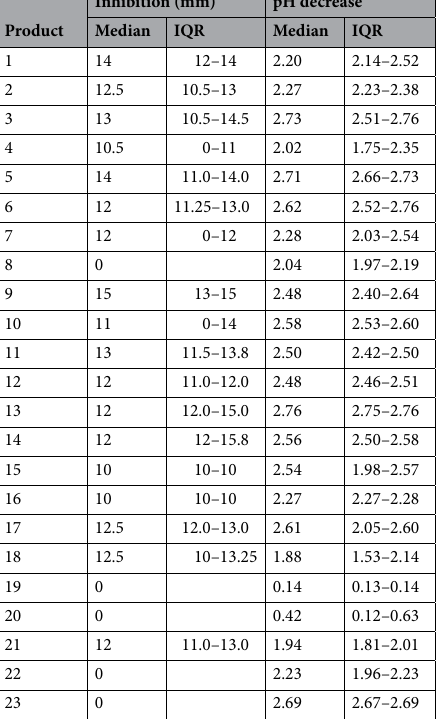
Table 1. Measurements of S . mutans inhibition and pH reduction in the culture medium of the different foods analyzed.